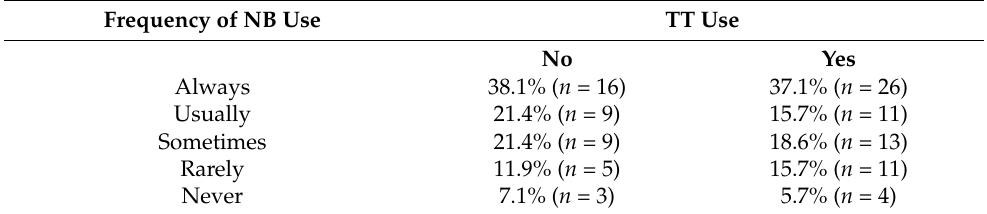
Table 3. Distribution of NB use for respondents who never use TTs ( n = 42) and do use TTs ( n =